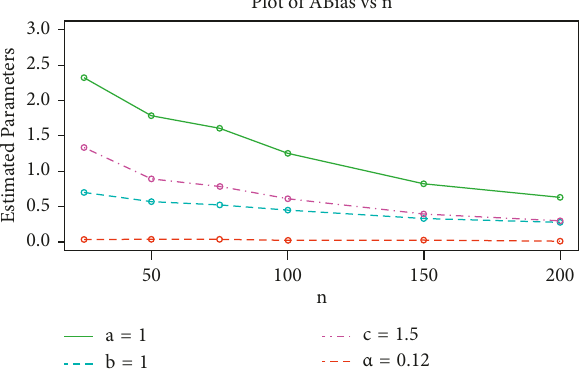
Figure 6: The plots of ABs for the ExEW parameters in set IV.